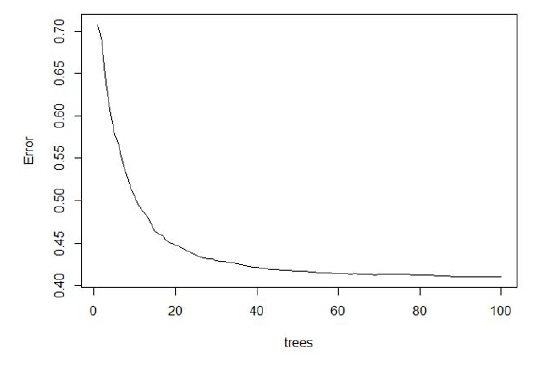
Figure 8. Error reduction with increasing number of